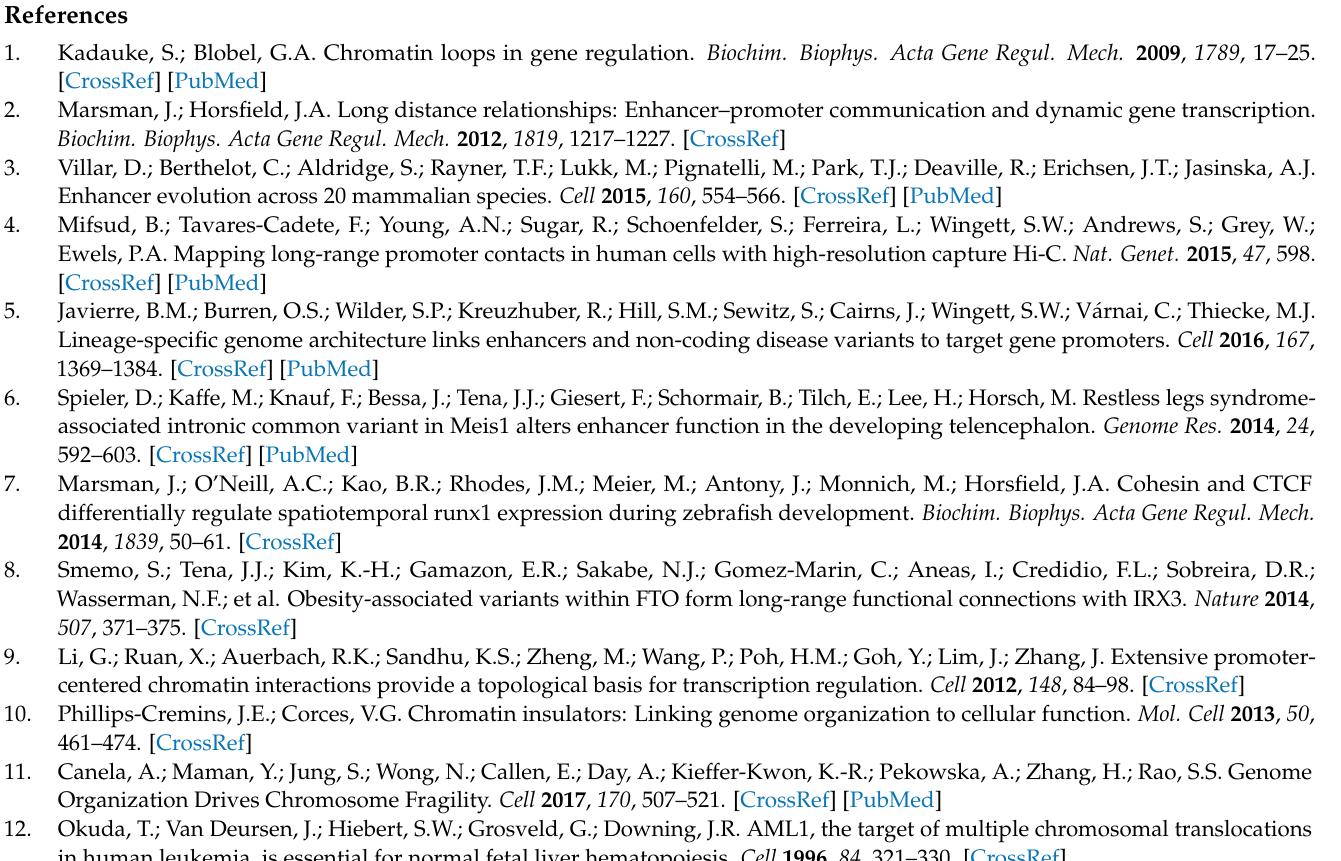
R1Res. Table S3: FATHMM prediction of the functional consequences of non-coding mutations of previously identified